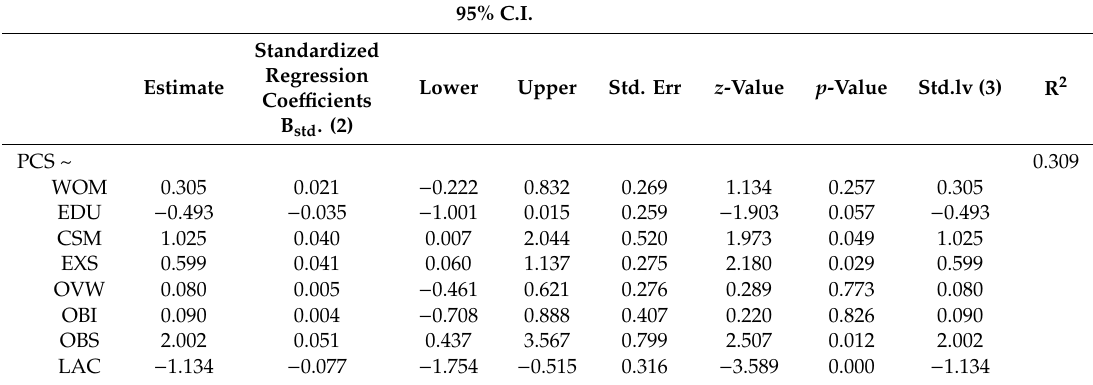
Table 3. Path model’s parameters